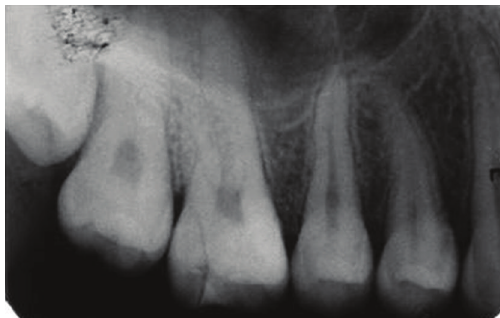
Figure 1: Oblique fracture of distofacial cusp with 16 with loss of mesiopalatal cusp with 16.